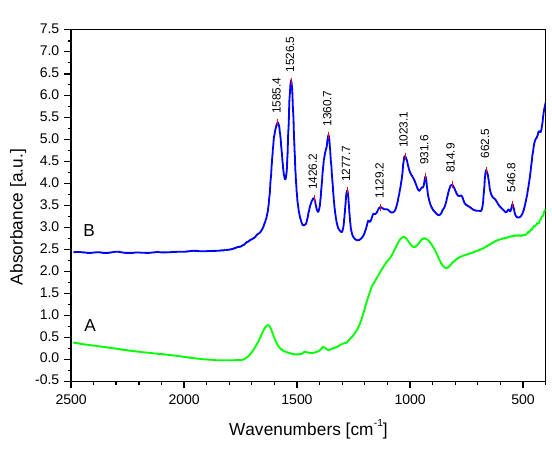
bands characteristic of crystalline materials (Fig. 4). If so, XPS results served. On the other hand, sols with ACC are much